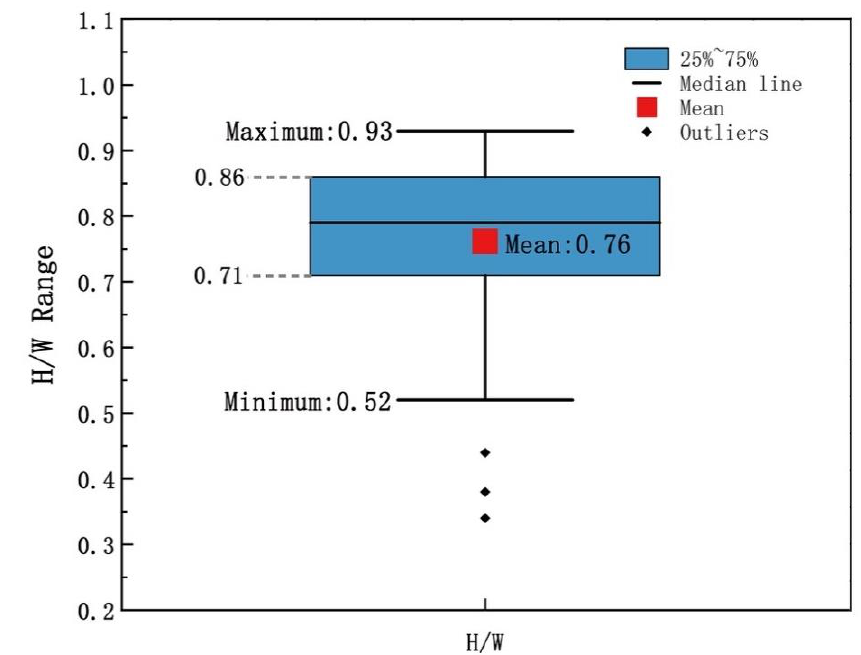
Figure 9. Box plot of H/W (the ratio of height and road width).